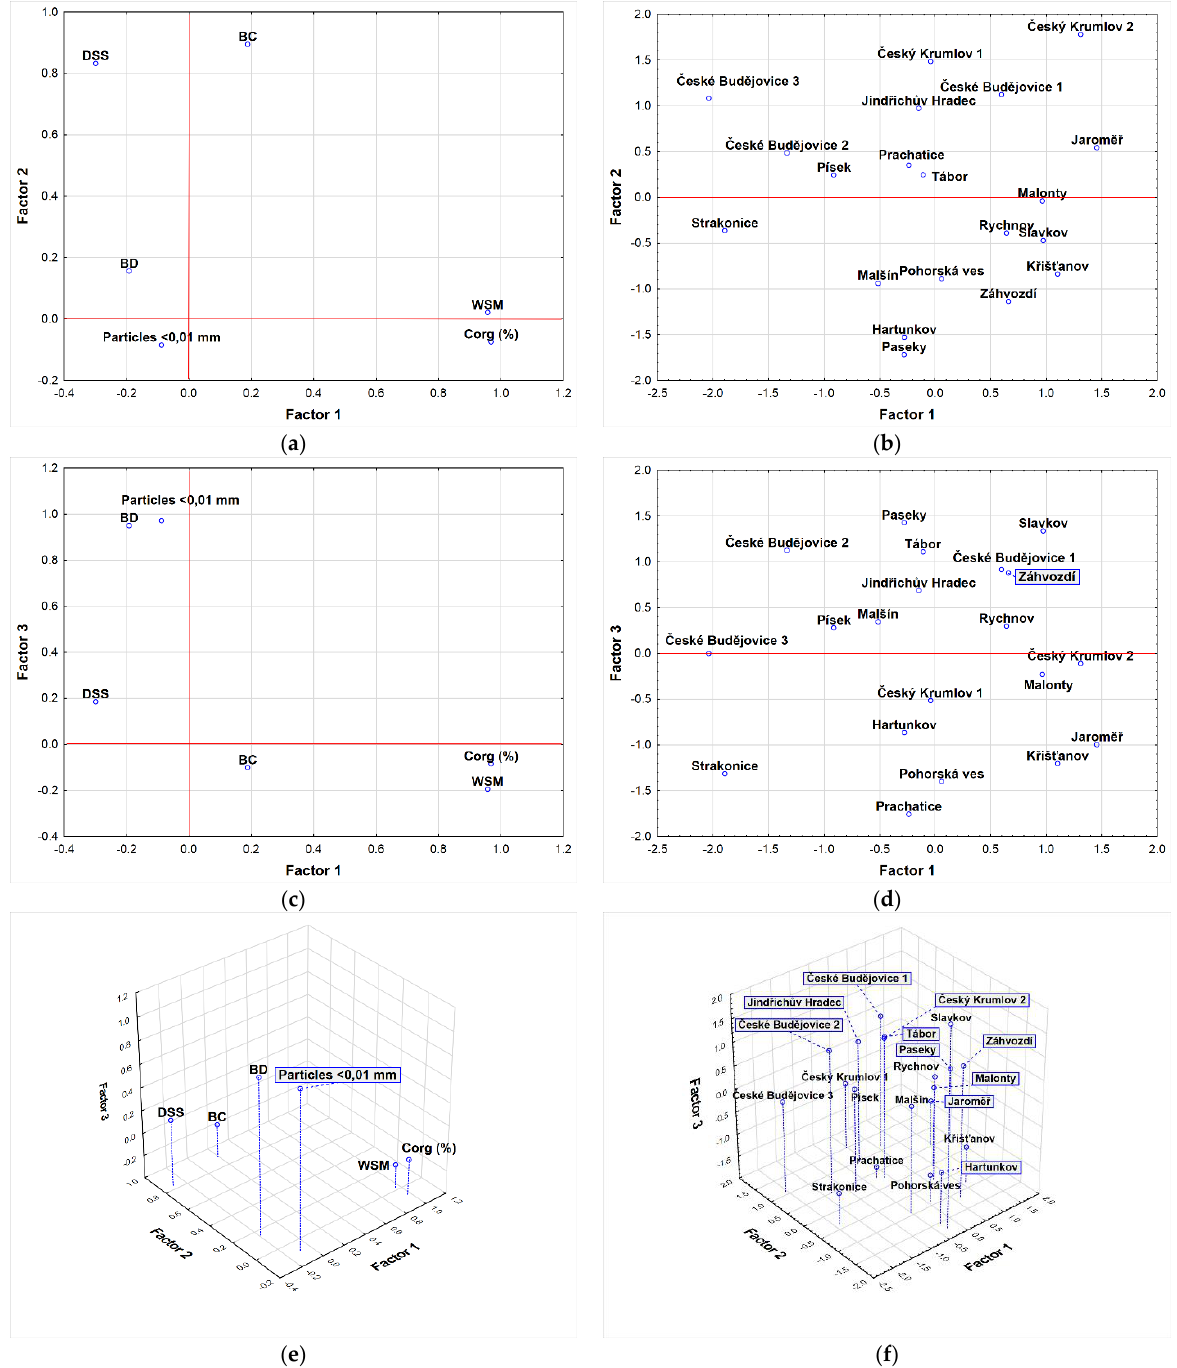
Figure 4. Factor analysis (FA) of soil quality parameters in the area of interest: ( a ) graph of factor weights (Factor 1 × Factor 2) for soil quality parameters. ( b ) Scattering diagram of component scores Factor 1 × Factor 2 for individual localities. ( c ) Graph of factor weights (Factor 1 × Factor 3) for soil quality parameters; ( d ) scattering diagrams of component score Factor 1 × Factor 3 for individual localities; ( e ) 3D graph Factor 1 × Factor 2 × Factor 3 for soil quality parameters; ( f ) 3D graph Factor 1 × Factor 2 × Factor 3 for individual localities. Note: BC — black carbon (% C org ); fLFOM/oLFOM — the ratio of free light fraction and the occluded light fraction of soil organic matter; WSM — water-stable macroaggregates (g aggregates ⋅ (kg soil after sand subtraction) −1 ); particles < 0.01 mm — clay particles; C org — soil organic carbon (%); DSS — degree of sorption saturation (%); BD — bulk density (g/cm 3 ).